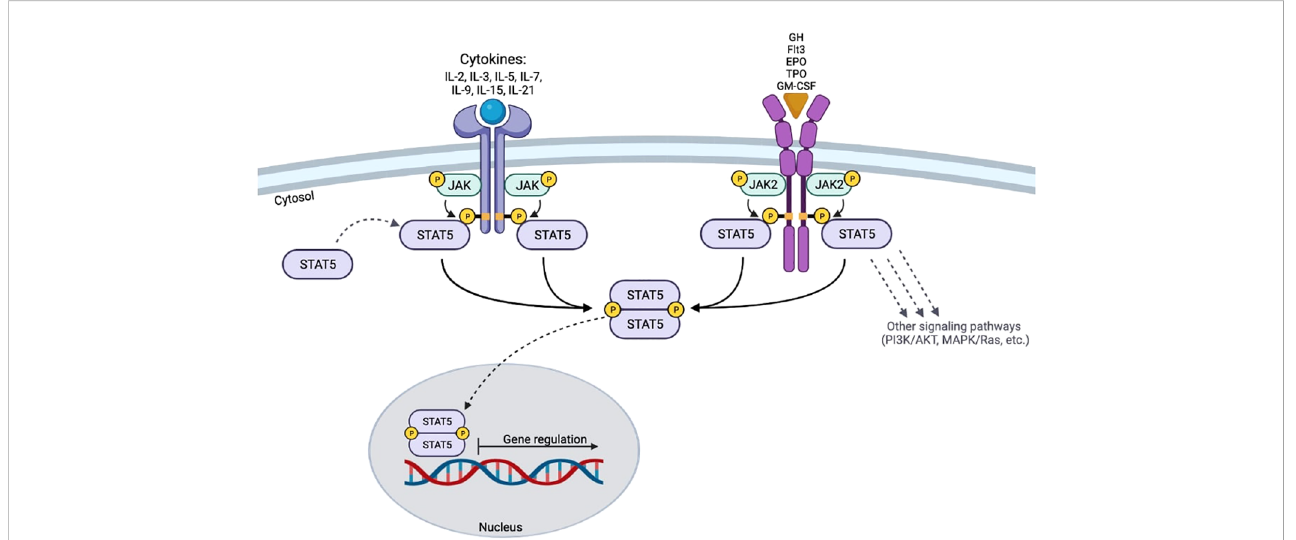
FIGURE 2 Schematic of STAT5 signaling. The activation of STAT5 requires the binding of cytokines or growth factors to their respective receptors. The cytoplasmic domains of the receptors are trans-phosphorylated by activated JAK proteins. STAT5 proteins then bind to the receptor and become activated by trans- phosphorylation at their speci fi c tyrosine residues. After activation, STAT5 dimerizes and translocates to the nucleus to induce gene